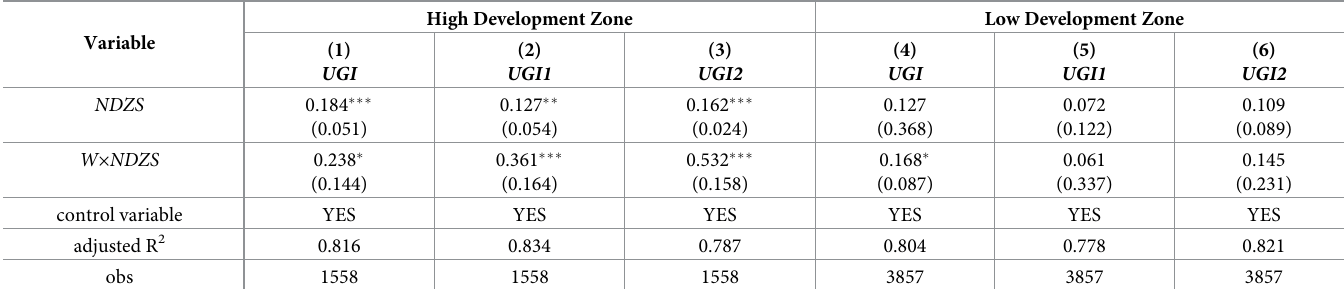
Table 8. Heterogeneity test: High level of development vs.low level of development. Variable